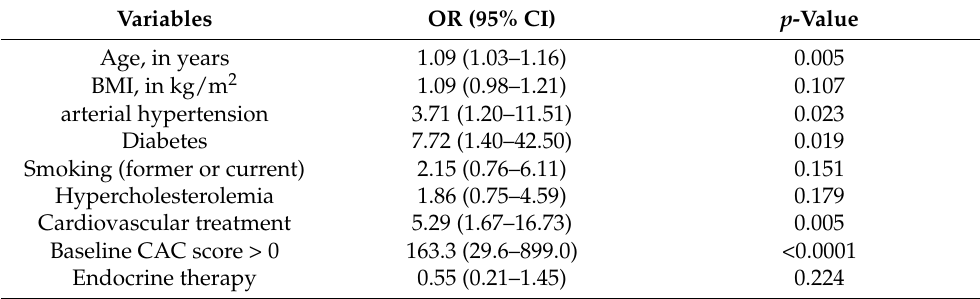
Association between CAC progression (yes/no) and non-radiation cardiovascular risk